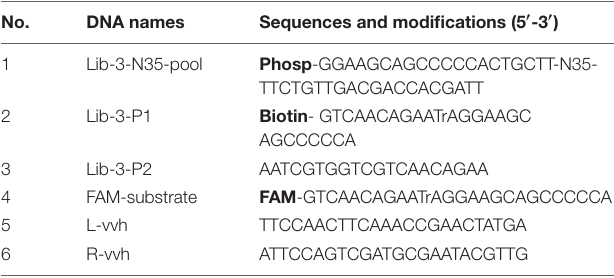
TABLE 1 | DNA sequences related to in vitro selection.